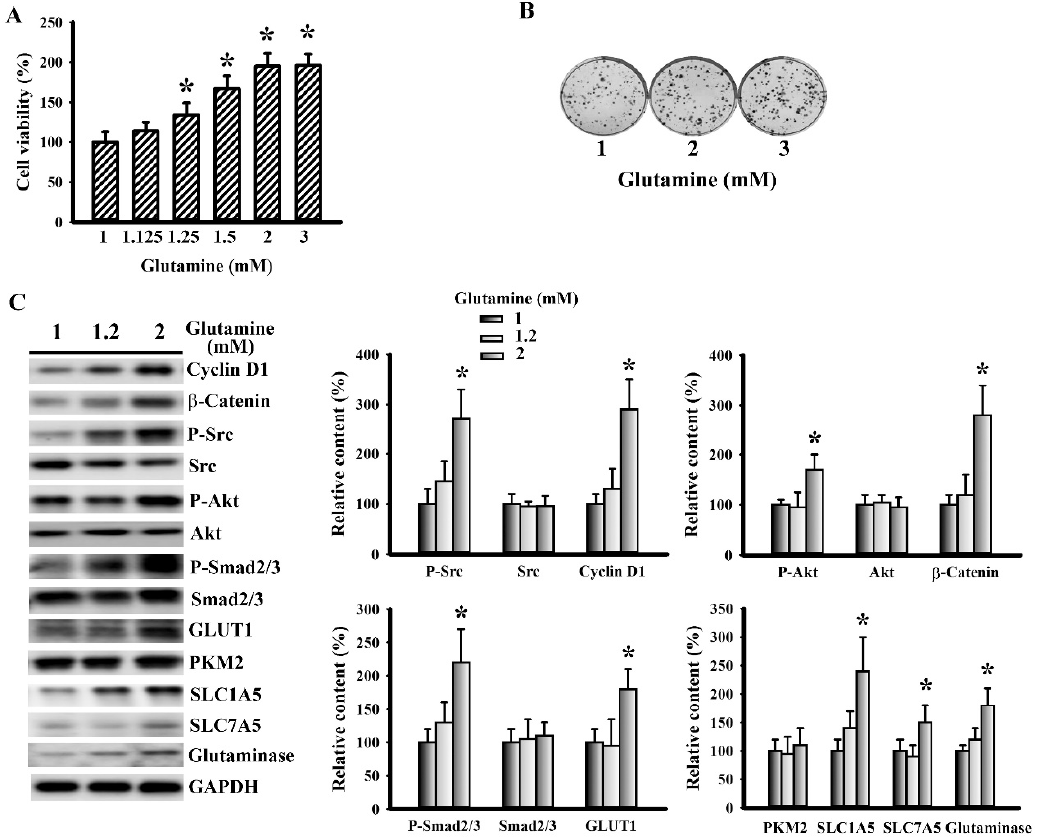
Figure 7. Glutamine promoted LLC cell proliferation. ( A ) LLC cells were treated with various concentrations of glutamine for 24 h. Cell viability was evaluated by MTS reduction assay. ( B ) LLC cells were treated with various concentrations of glutamine for 6 days. Cell colonies were fixed and stained with crystal violet. ( C ) LLC cells were treated with various concentrations of glutamine for 16 h. Proteins were extracted and subjected to Western blot with indicated antibodies. Representative blot is shown. Quantitative data are depicted and the content in untreated control was defined as 100%. * p < 0.05 vs. untreated control (n = 3).